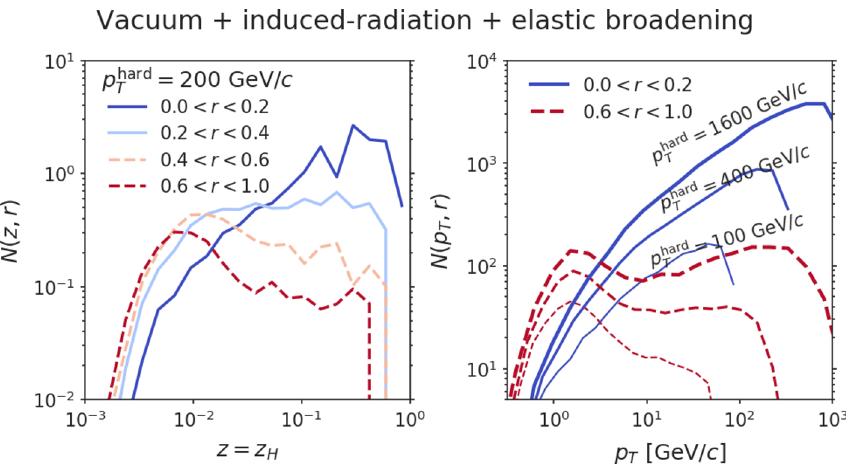
Figure 7 . Energy distribution E ( z H , r ) that includes effects from radiative processes (vacuum plus medium-induced) and elastic broadening effects. Left: E ( z radii. Right: E ( p ) at small and large radii for p hard T , r